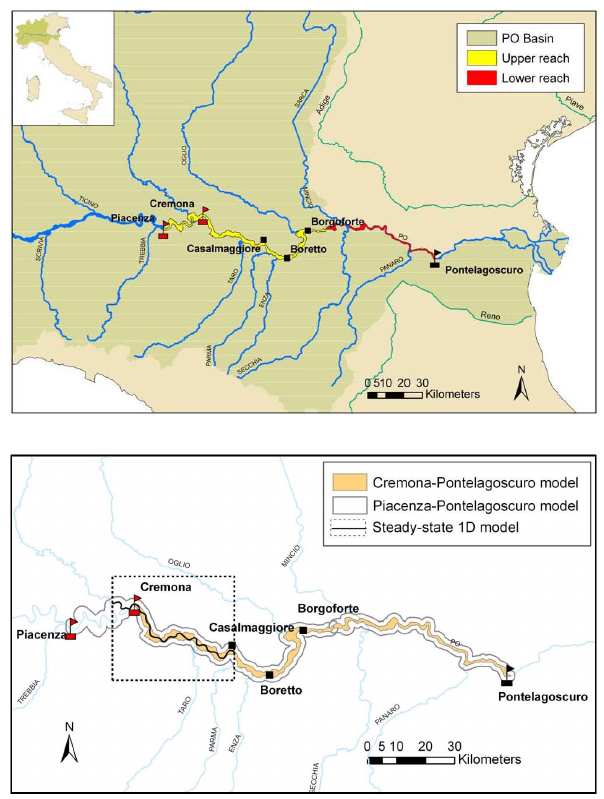
Fig. 1. Po River: upper and lower portions of the study reach; Pia- cenza, Cremona and Pontelagoscuro gauging stations